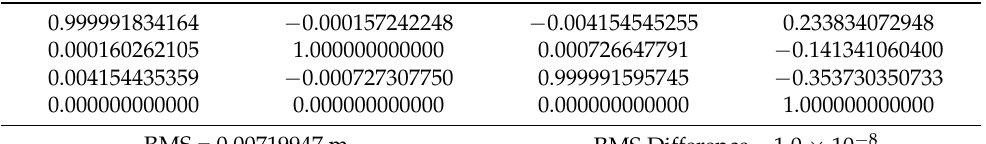
Table 3. Second precision registration coordinate transformation matrix of the two-phase rock mass point cloud.